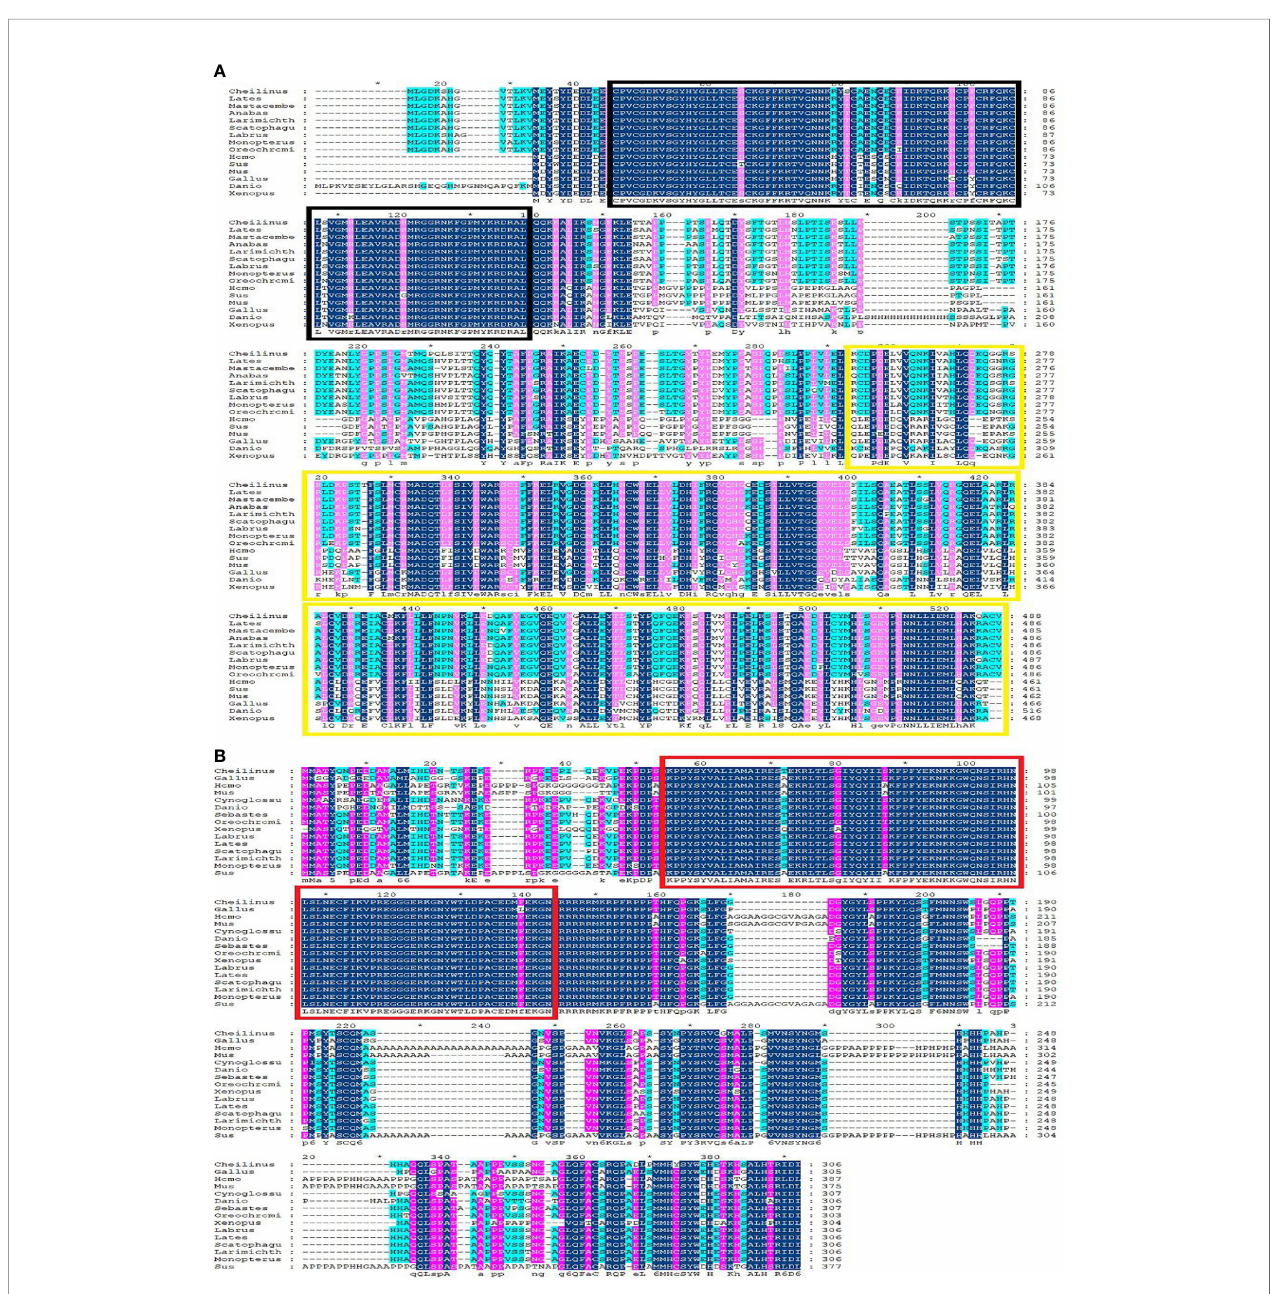
FIGURE 2 | Amino acids sequence alignment of C. undulates SF-1 and FOXL2 . (A) Amino acids sequence alignment of C. undulates SF-1 . The black box represents the conserved DNA binding domain (DBD). The yellow box represents the C-terminal ligand binding domain (LBD). (B) Amino acids sequence alignment of C. undulates FOXL2 . The red box represents the conserved Forkhead (FH)